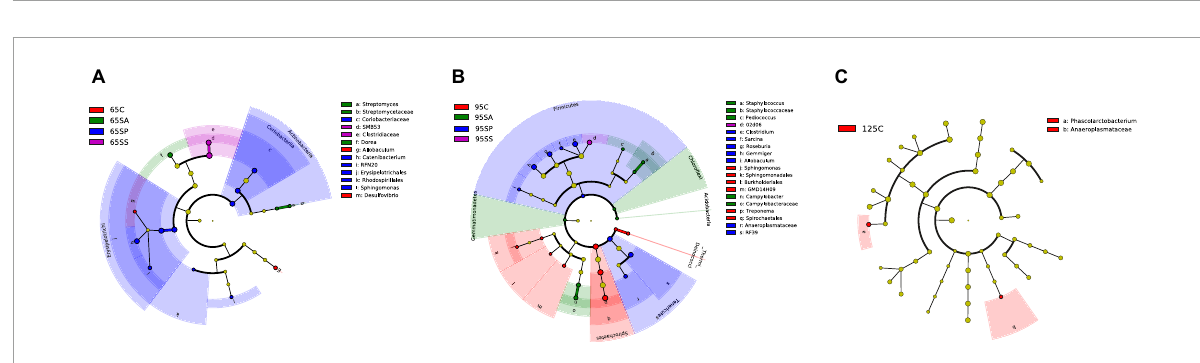
FIGURE3 Different enrichment of microbiota in colonic contents of offspring pigs. Analysis of taxonomic abundance using linear discriminant analysis effect size (LEfSe analysis) (LDA score ≥ 2, P < 0.05) in colonic contents of offspring pigs at 65 (A) , 95 (B) , and 125 (C) days of age. The cladogram shows the microbial species with a significant difference between the experimental groups and the control group. 65C, 95C, and 125C, sow fed with basal diet; 65SA, 95SA, and 125SA, sow fed with antibiotic; 65SP, 95SP, and 125SP, sow fed with probiotics; 65SS, 95SS, and 125SS, sow fed with